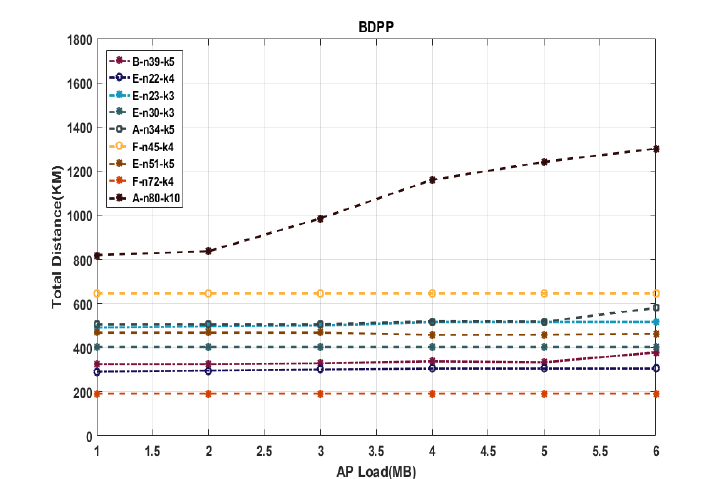
Figure 9. AP load vs. total distance